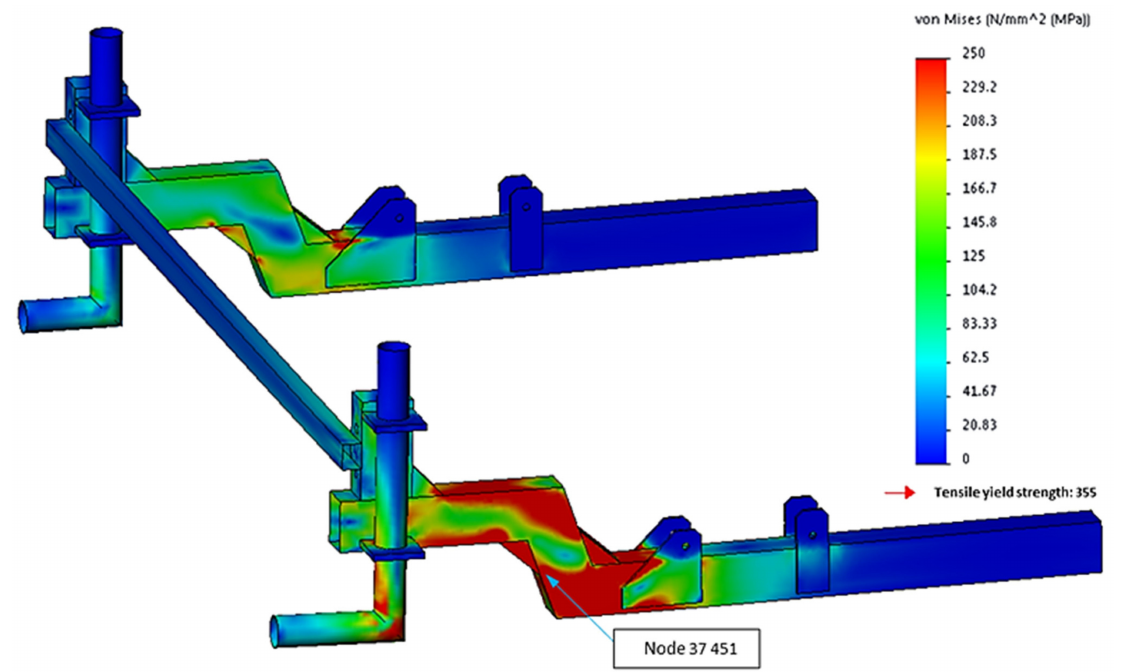
Figure 14. The mechanical stress in the structurally and materially (S355J0) optimized frame solution at the limit state of stability.